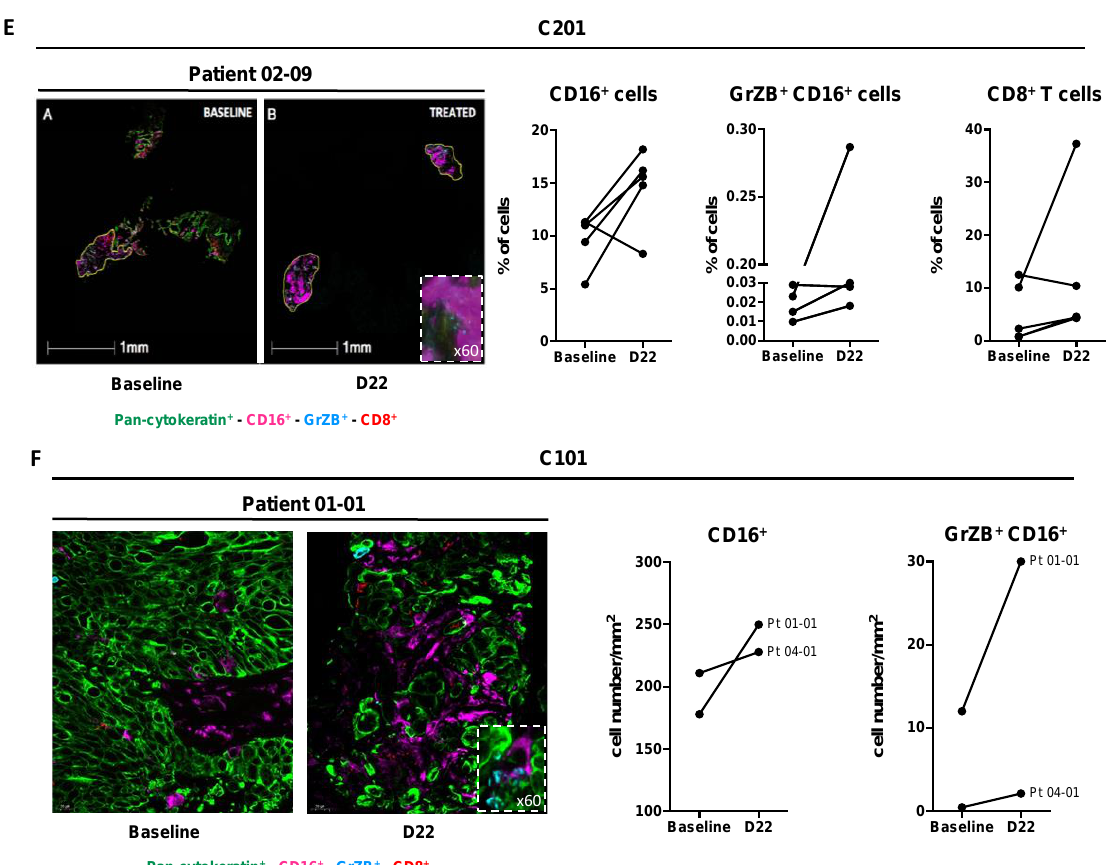
Figure 1. Variation of pharmacodynamic markers measured in blood samples and biopsies of patients from C201 and C101 studies. ( A ) Detection of CD69 as a marker of activation of monocytes, regulatory and CD8 + T cells in blood samples of patients ( n = 20) with colorectal cancer treated with murlentamab (single agent and in combination with trifluridine/tripiracil). Data shown (boxplots) are the results from 20 patients. * p < 0.05; ** p < 0.01. p values were determined using one-way ANOVA analysis followed by Tukey’s multiple comparisons test. ( B ) Detection of ICOS (inducible co-stimulatory molecule) as a marker of lymphocyte activation in blood samples of patients with ovarian cancer treated at Gustave Roussy (Paris, France) with murlentamab in combination with carboplatin + paclitaxel ( n = 4). ( C ) Detection of CXCL9 ( n = 16) and CXCL10 ( n = 15) release in blood samples of all patients treated with murlentamab single agent in C201. ( D ) Detection of co-staining CD14/CD163 ( n = 8) and of ICOS ( n = 4) as markers of immune system regulation in FFPE (Formalin-Fixed Paraffin-Embedded) biopsies obtained from the C201 study. ( E ) Image and quantification of CD16 ( n = 5), co-staining CD16/granzyme B (GrZB) ( n = 4), and CD8 ( n = 4) as markers of immune system activation in FFPE biopsies obtained from the C201 study. ( F ) Image and quantification of CD16/granzyme B (GrZB) co-staining in FFPE biopsies obtained from the C101 study ( n =